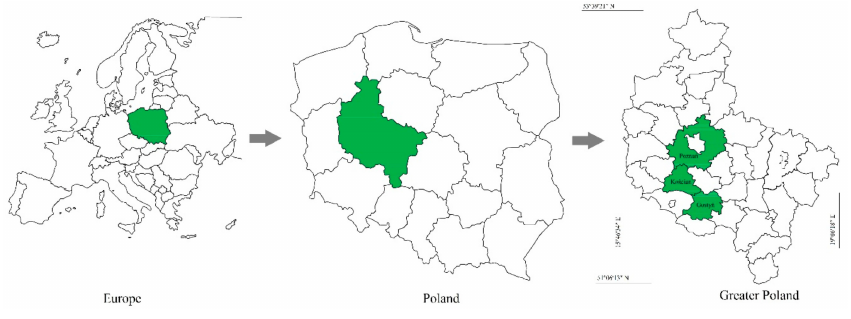
Figure 1. Research area—Greater Poland, Poland (redraw from [19]). Table 1. The number of productive fields of winter rapeseed divided into two sets, A and B [19]. Set A Set